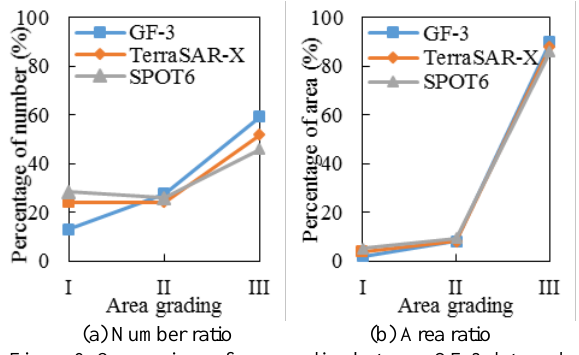
Figure 9. Comparison of area grading between GF-3 data and reference data